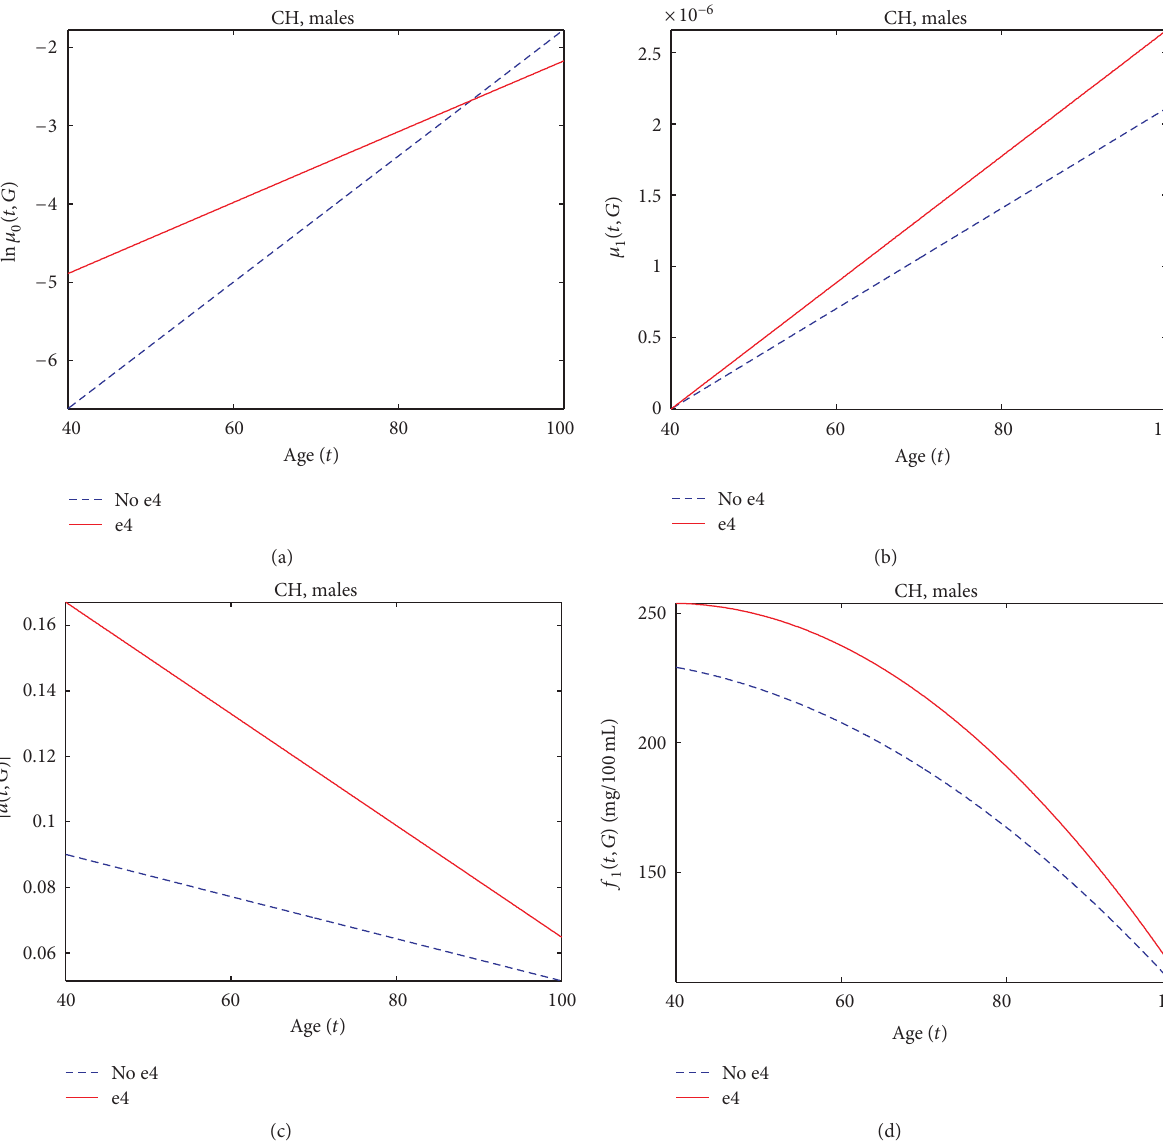
F 5: Application of the genetic stochastic process model to longitudinal measurements of total cholesterol (“CH”) and data on mortality for males in the Framingham Heart Study (original cohort). Estimates of the logarithm of the baseline hazard (a), the multiplier in the quadratic part of the hazard (b), the adaptive capacity (the absolute value of the feedback coefficient) (c), and the mean allostatic trajectory (d) for carriers (“e4”) and noncarriers (“No e4”) of the APOE e4 allele. e null hypotheses on the equality of the mean allostatic trajectories in carriers and noncarriers (column “ ” 𝐺𝐺 𝑓𝑓 1 𝑎𝑎